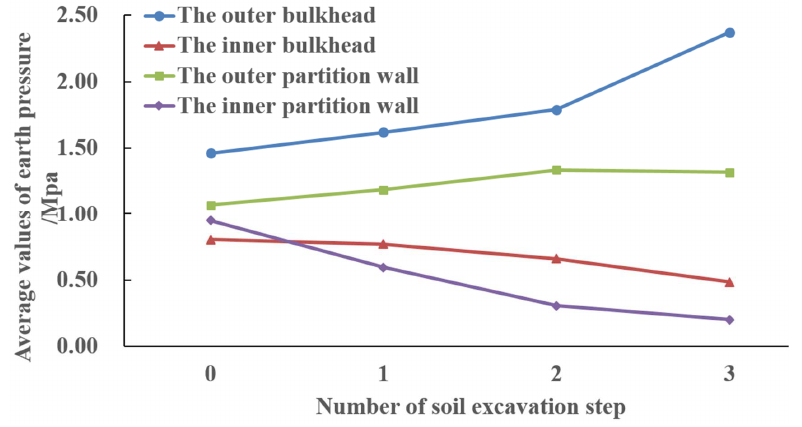
Figure 18. Averages of the field measured soil pressure with soil excavation step. Before soil excavation, the average earth pressure of the outer bulkhead area is 1.46 MPa which is the biggest, it is about 1.07 MPa in the outer partition wall area, and the earth pressure of inner partition wall and inner bulkhead area was 0.95 MPa and 0.81 MPa respectively. After the first stage of soil excavation, the earth pressure of outer bulkhead increased from 1.46 MPa to 2.37 MPa, while the earth pressure of the inner partition wall area gradually deceased from 0.95 MPa to 0.20 MPa, and the earth pressure in the inner bulkhead area was also decreased from 0.81 MPa to 0.49 MPa. For the earth pressure in the outer partition area, it slightly increased from 1.07 MPa to 1.32 MPa. Due to the